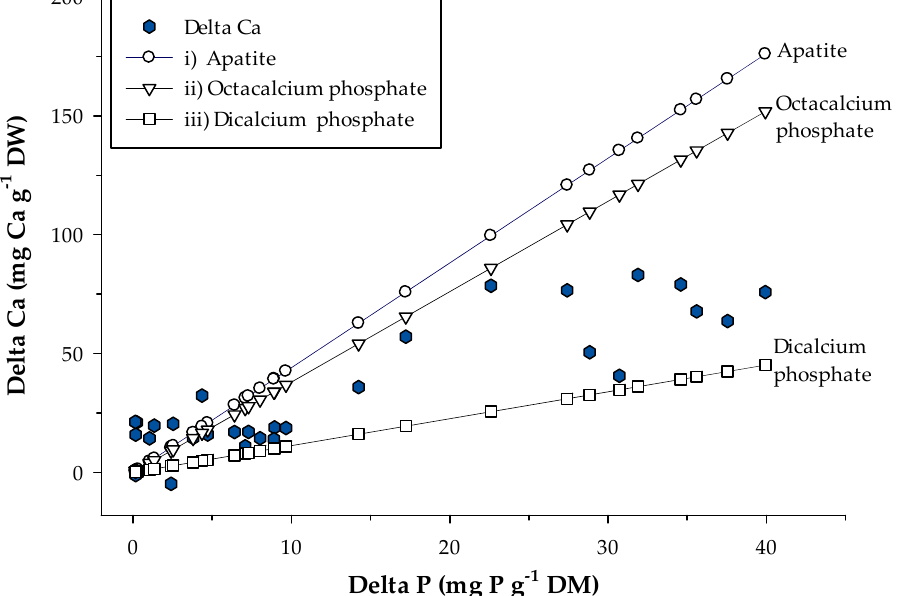
Figure 5. Delta Ca plotted against delta P. The blue filled symbols shows the delta Ca and the delta P content, which is the element content measured in the fractions after termination subtracted the initial measured element content (in the original material). The non-filled symbols shows three calculated delta Ca scenarios based on calcium-phosphate precipitation: (i) Apatite (Ca 5 (PO 4 ) 3 OH),(ii) Octacalcium phosphate (Ca 4 H(PO 4 ) 3 ), and (iii) Dicalcium phosphate (CaHPO 4 ). See result text for more information about the scenarios.